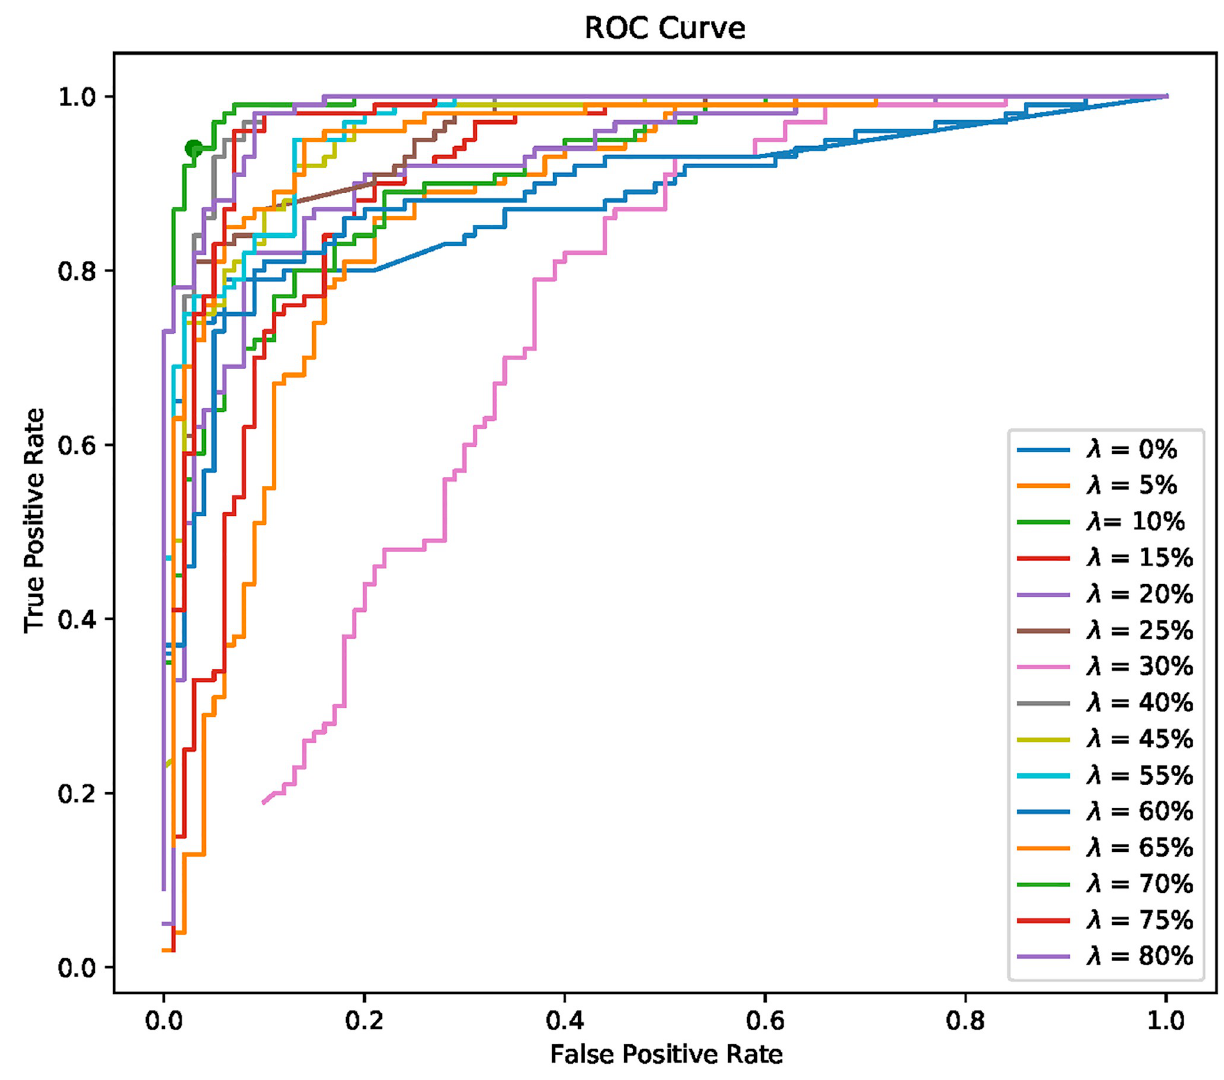
Fig 4. ROC curve of every